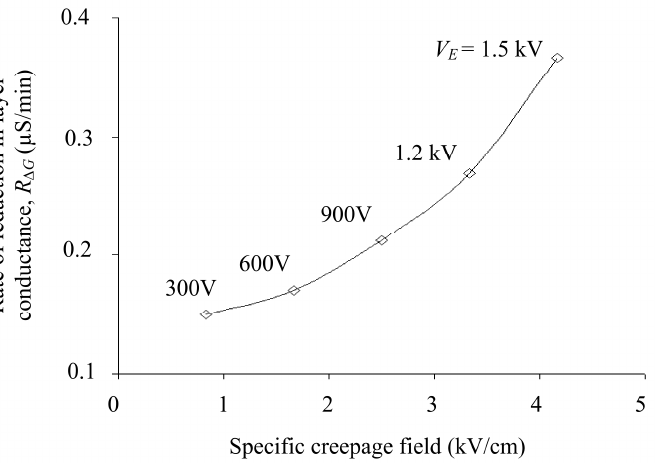
Figure 9. Rate of change in surface conductance as a function of specific electric field on polluted insulator energized with different voltage levels.